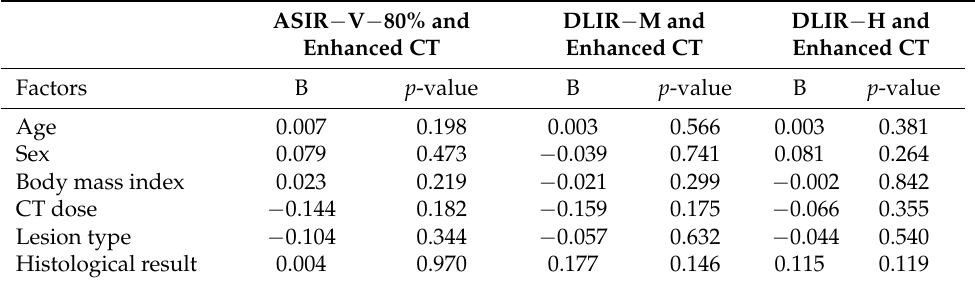
Table 6. Multiple linear regression analysis of the influential factors on measurement difference of measurable target lesions between ultra-low-dose CT and contrast-enhanced CT.